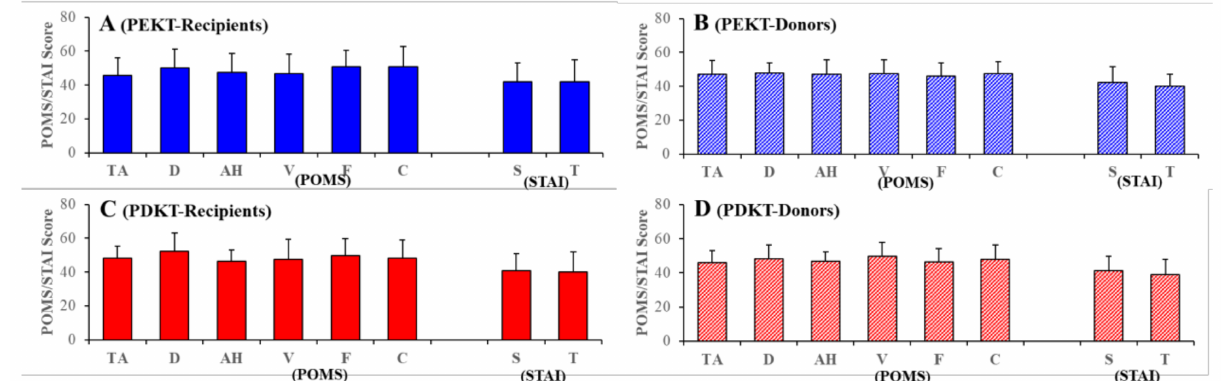
Figure 3. Scores for the Profile of Mood States (POMS) and State–Trait Anxiety Inventory (STAI) for the recipients ( A , C ) and donors ( B , D ) of PEKT ( A , B ) and PDKT ( C , D ). Ordinates indicate the mean SD of the scores of POMS and STAI. POMS is ± composed of 6 subscales: “tension/anxiety” (TA), “depression” (D), “anger/hostility” (AH), “vigour” (V), “fatigue” (F) and “confusion” (C). STAI is composed of two subscales: “state anxiety” (S) and “trait anxiety” (T).